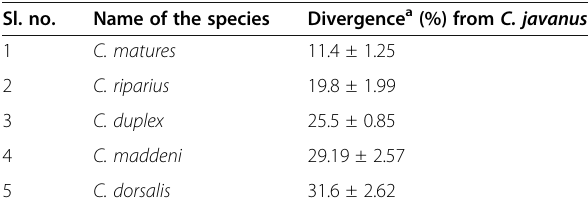
Table 3 Degree of divergence of five Chironomus species from C. javanus Sl. no.